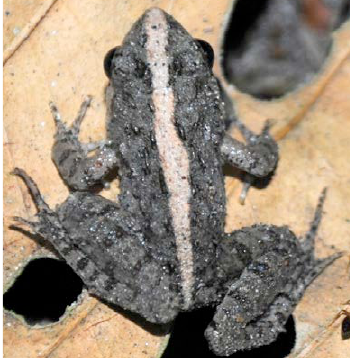
Image 5. Fejervarya teraiensis, Gelephu, Sarpang. © Dorji Wangchuk